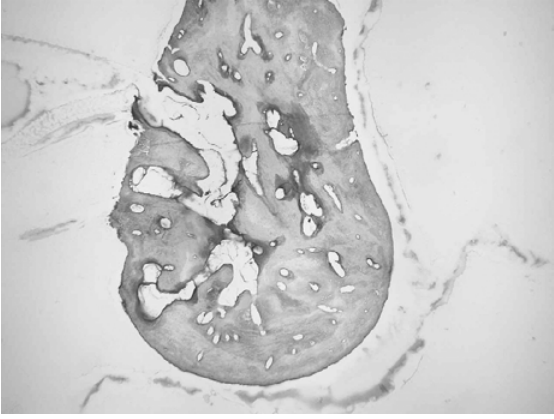
Figure 2. Histological cross-section of incus after mechanical treatment and autoclaving (decaltification, haematoxylin and eosin staining, magnification 100 x). The surface of the incus is without epithelium, the inner cores of the ossicle are without lymphocyte infiltration.